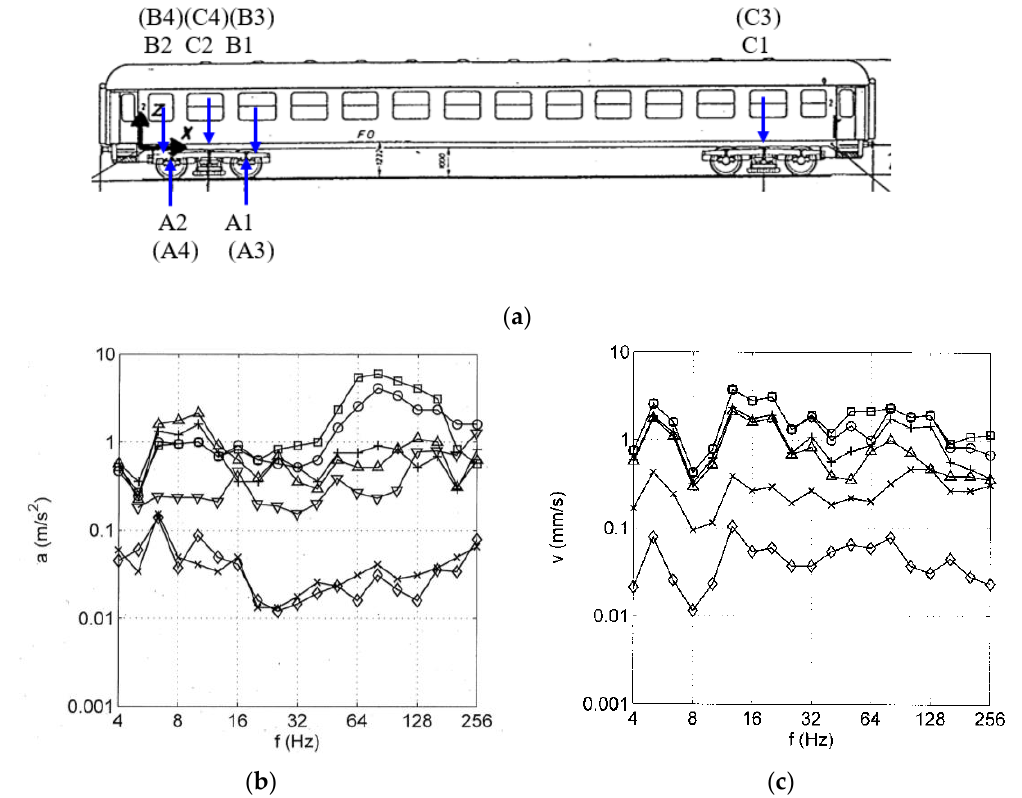
Figure 1. ( a ) Measurement points of the railway vehicle (passenger car) for the test runs, axle boxes A1, A2, bogie B1 and B2, carriage C1 and C2, right hand side, A3, A4, B3, B4, C3, C4 symmetrically on the left hand side; ( b ) one-third octave band spectra of the accelerations of the railway vehicle running with v T = 160 km/h, , wheelset A1 and A2, , vertical bogie part B1 and B2, horizontal bogie part B1, , car body part C1 and C2; ( c ) particle velocities of the track , left and right rail, , sleeper 1 and 2, , sleeper horizontal, sub soil at 2.5 m distance.